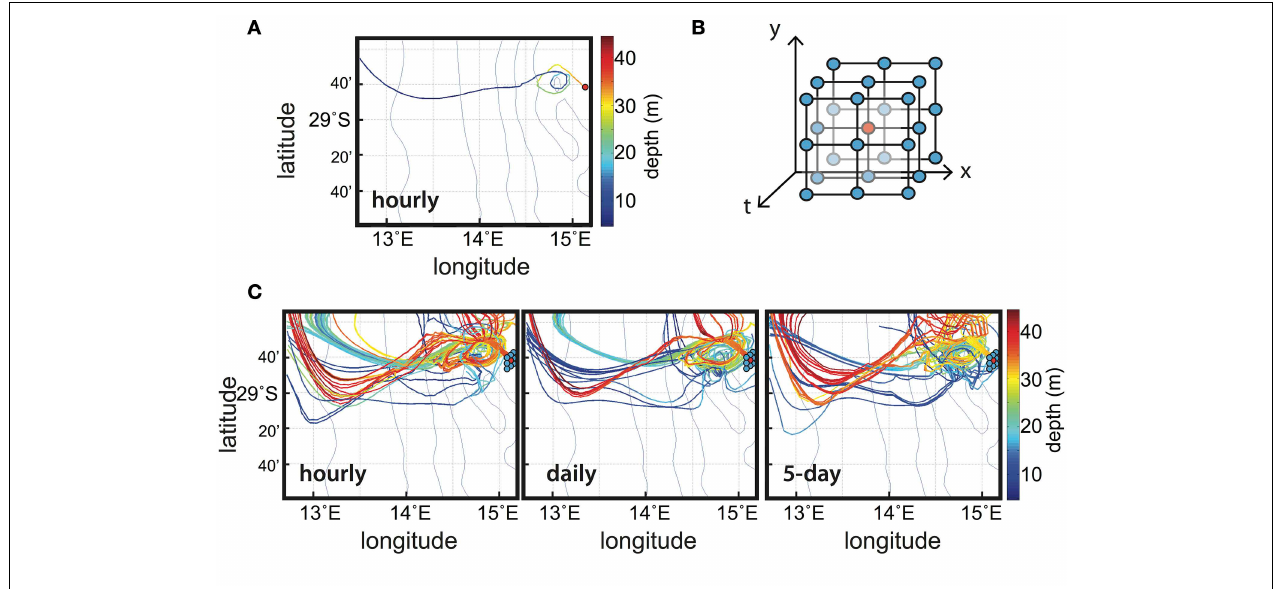
in the immediate neighborhood of the initial position (the red dot). (C) Trajectories of the particles initialized around the reference initial position for several sampling frequencies of the Eulerian model output: hourly (left), daily (middle), and 5-day (right). In (A,C) the color bar shows depth (in m) along